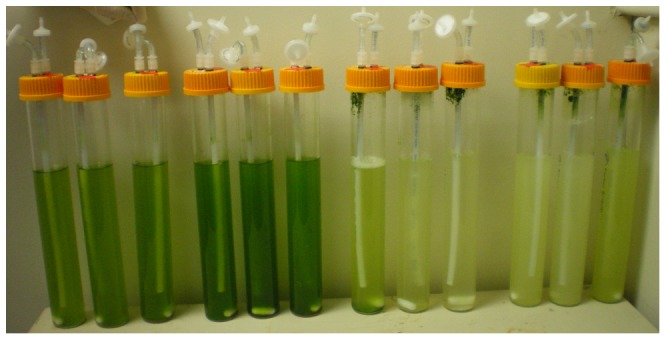
Bio-fouling in glucose co-cultures.From left to right in triplicate: 0 g/L glucose, 0.5 g/L glucose, 2 g/L glucose, 10 g/L glucose. Similar fouling occurred in glycerol and acetate co-cultures. A film of algae can be seen on the upper wall of reactors under high glucose concentrations.